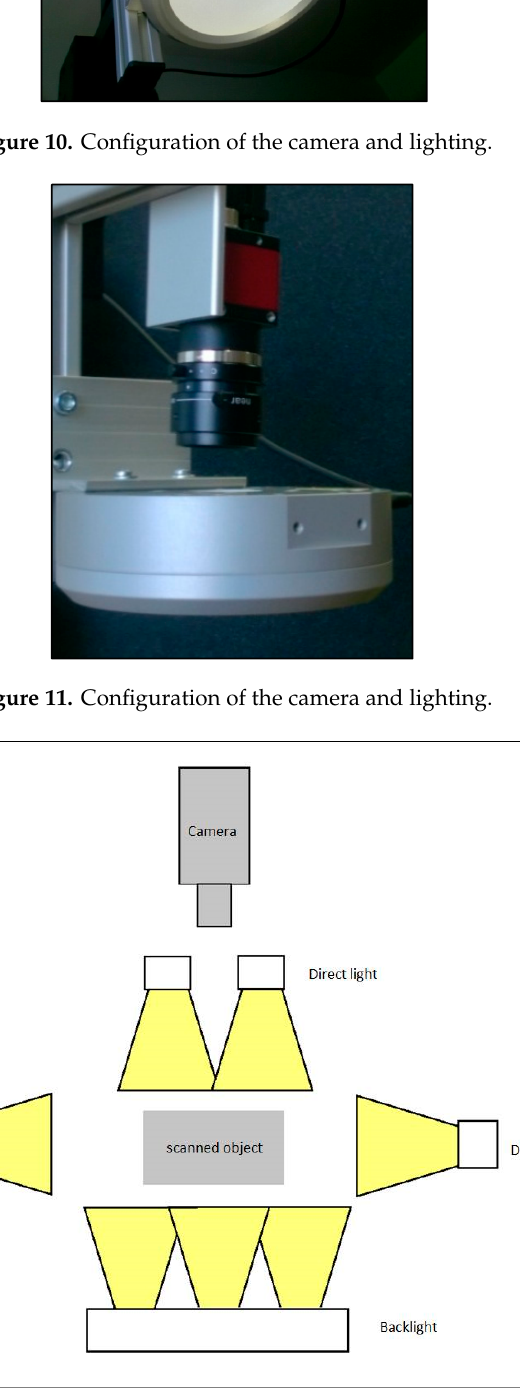
Figure 12. Possible types of lighting within the scene.